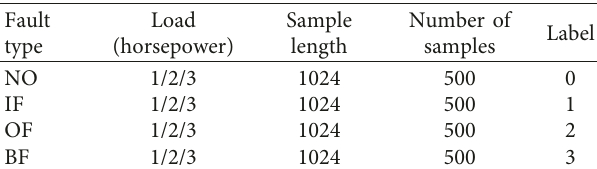
Figure 3: The structure of the proposed 1DCNN-GRU model. Table 1: Description of the experimental